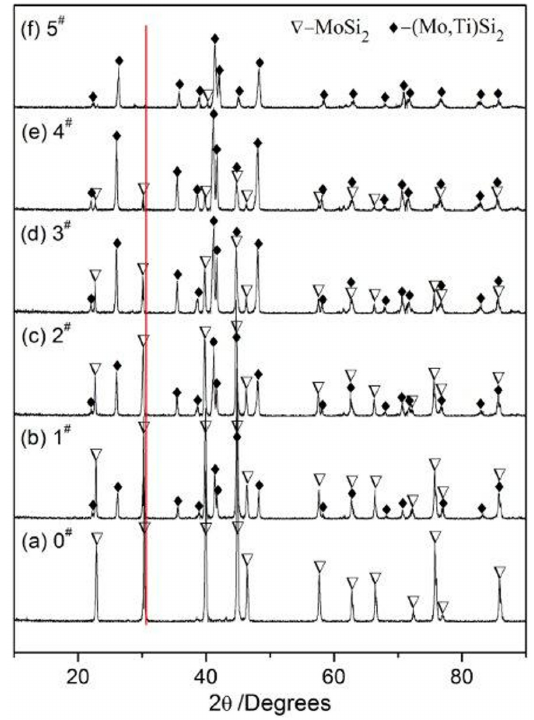
Figure 7. X−ray diffractions patterns of the combustion products with different starting nominal